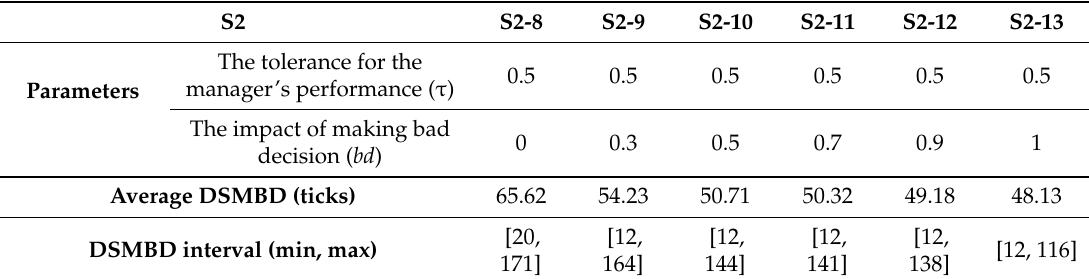
Table 9. Simulation’s results for S2 when τ =